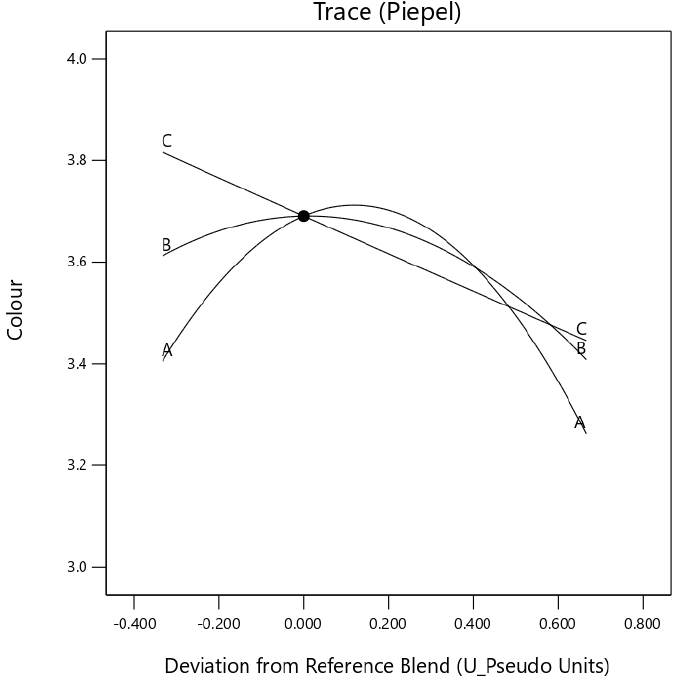
Figure 3. Trace (Piepel) plot for the effect of three components on colour (A: boiled egusi grit, B: flour and C: hydrocolloid) on instant egusi soup.